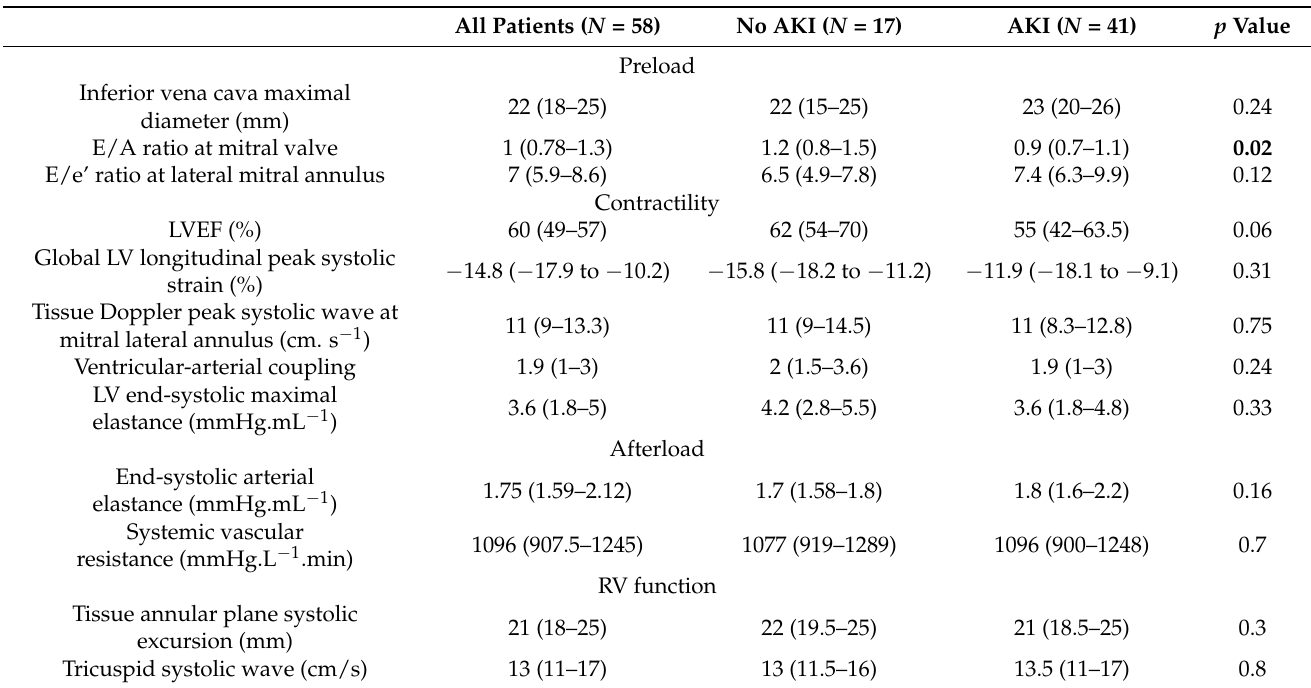
Table 2. Echocardiographic characteristics of critically-ill COVID-19 patients according to the occur- rence of acute kidney injury